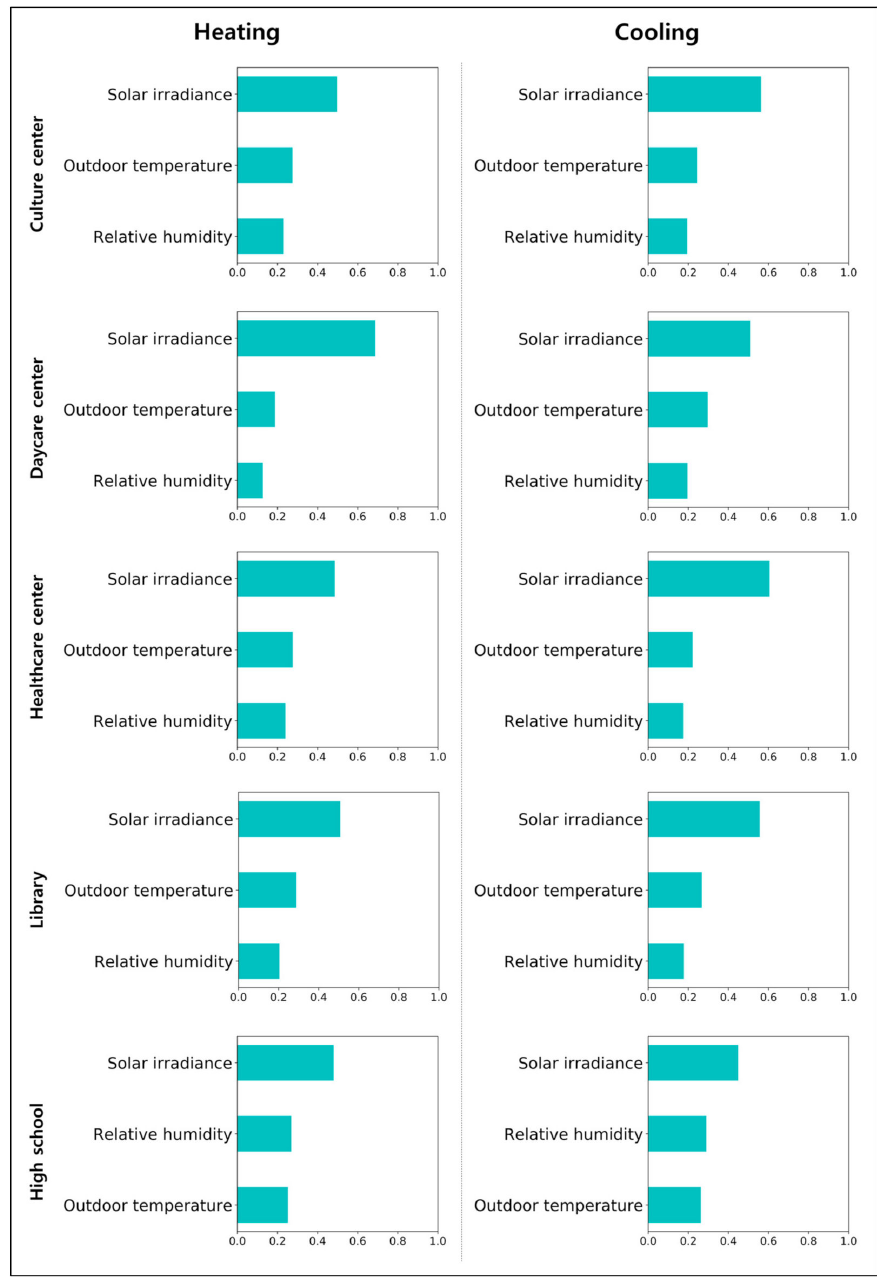
Figure 2. The results of prioritization using the Gini importance (outdoor environmental